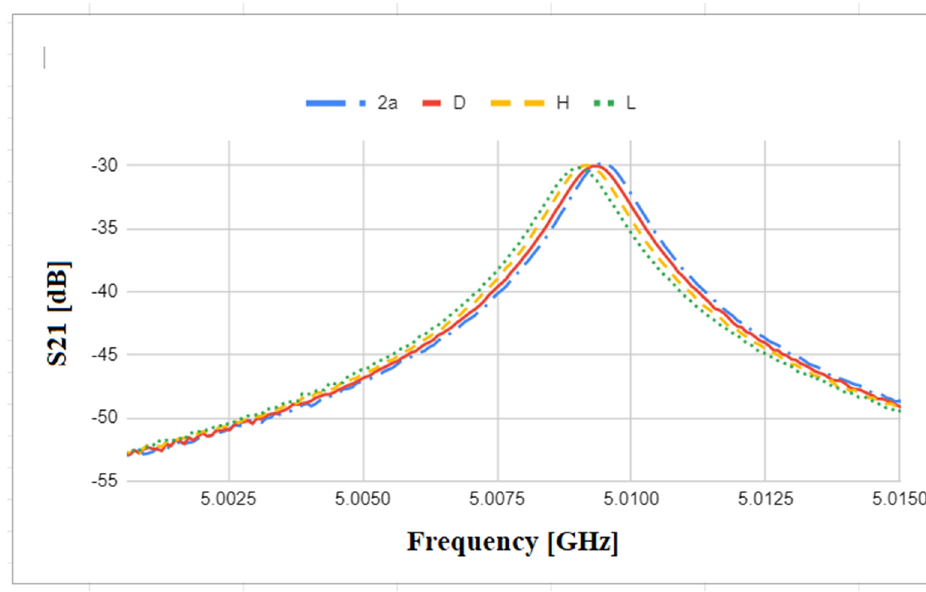
Figure 21. Location of the peaks of the master diamonds at 5.01 GHz.